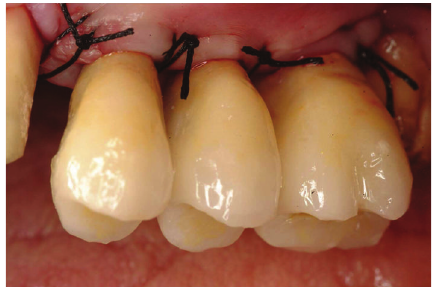
Figure 30: Delivery of the second set of